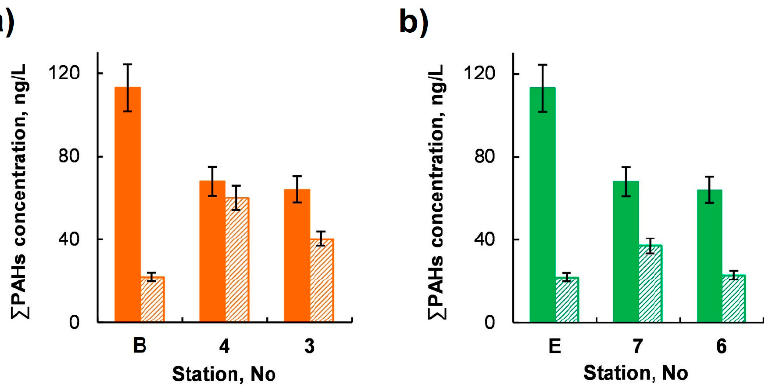
Σ PAH concentrations in the waters of the tributaries in the southern basin of Lake Baikal Figure 6. Ʃ PAH concentrations in the waters of the tributaries in the southern basin of Lake Baikal Figure 6. Ʃ PAH concentrations in the waters of the tributaries in the southern basin of Lake Baikal Figure 6. Ʃ PAH concentrations in the waters of the tributaries in the southern basin of Lake Baikal Figure 6. Ʃ PAH concentrations in the waters of the tributaries in the southern basin of Lake Figure 6. Ʃ PAH concentrations in the waters of the tributaries in the southern basin of Lake Baikal Figure 6.